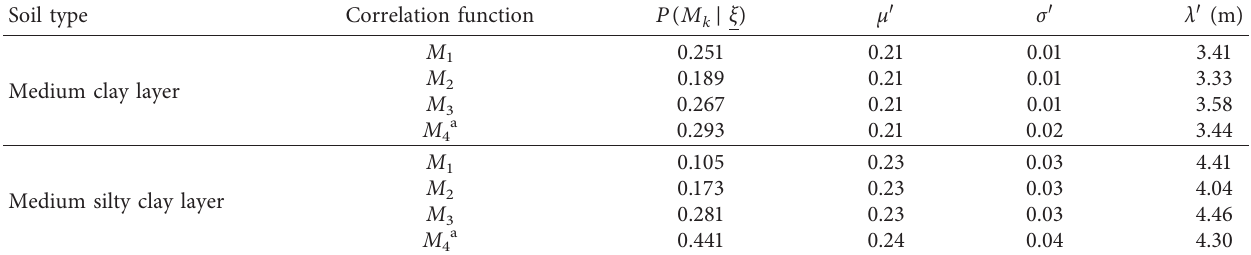
Figure 5: Modified Bartlett statistic profiles of CPT data for the medium silty clay layer. (a) M Table 3: Results of random field parameters and correlation function of r of the medium clay layer and medium silty clay layer obtained from the Bayesian